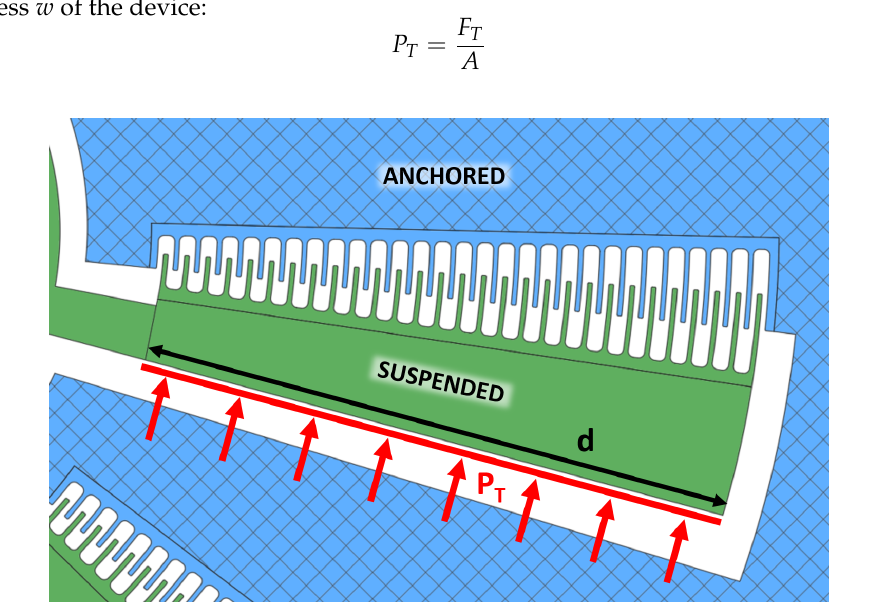
Figure 5. Electrostatic forces applied on the movable comb drive considered to be equivalent pressure on its backside surface.